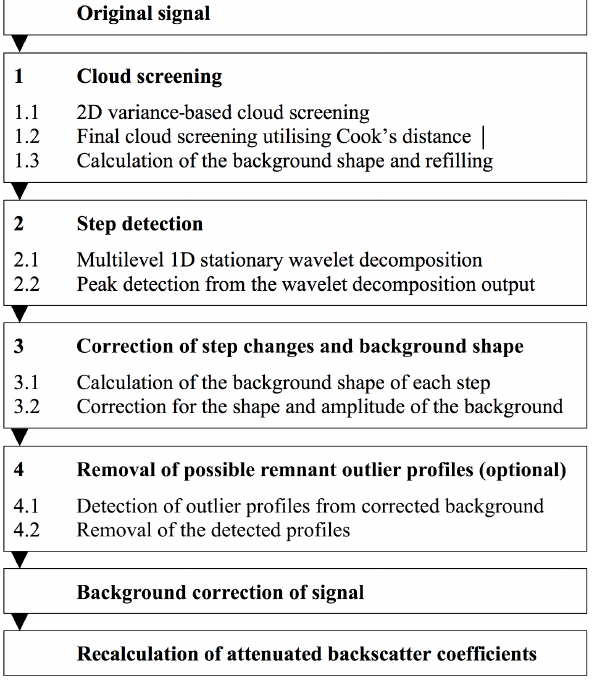
Figure 3. Chart showing the workflow of the Halo lidar background correction